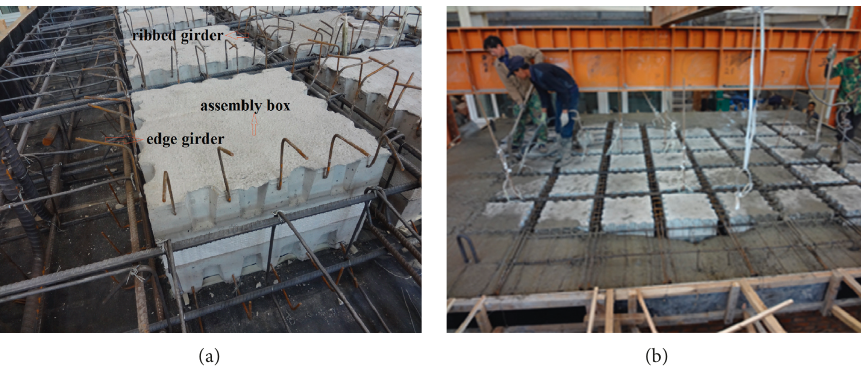
Figure 1: View of the AMH floor. (a) Before pouring concrete. (b) Pouring concrete.